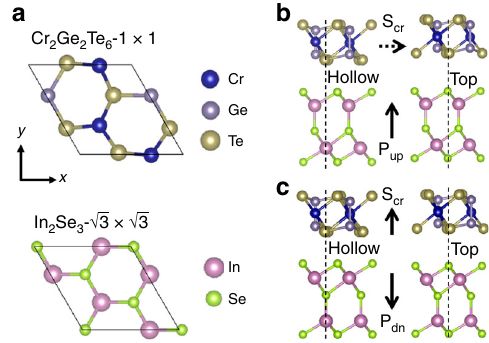
Fig. 1 Van der Waals Cr 2 Ge 2 Te 6 /In 2 Se 3 heterostructure and magnetoelectric coupling. a Lateral unit cell size is chosen to be equal to that of ferromagnetic Cr 2 Ge 2 Te 6 experimental lattice constant and ffiffiffi p ffiffiffi p ´ commensurate to ferroelectric In 2 Se 3 - 3 3 with − 4% strain. The interfacial two atomic layers (one atomic layer from each side of the interface) are shown in the top views of Cr 2 Ge 2 Te 6 -1 × 1 (top) and In 2 Se 3 - ffiffiffi p ffiffiffi p ´ 3 3 (bottom). b , c Heterostructure side views with the In 2 Se 3 ferroelectric dipole moment directed upward and downward ( P up and P dn ), respectively, and the induced easy-plane and easy-axis Cr spins ( S Cr ). The solid (dashed) arrow of S Cr indicates the allowed (prohibited) fi nite temperature long-range ferromagnetic ordering in 2D systems by the Mermin-Wagner theorem. For each case, the most stable (hollow) and unstable (top) stacking con fi gurations are